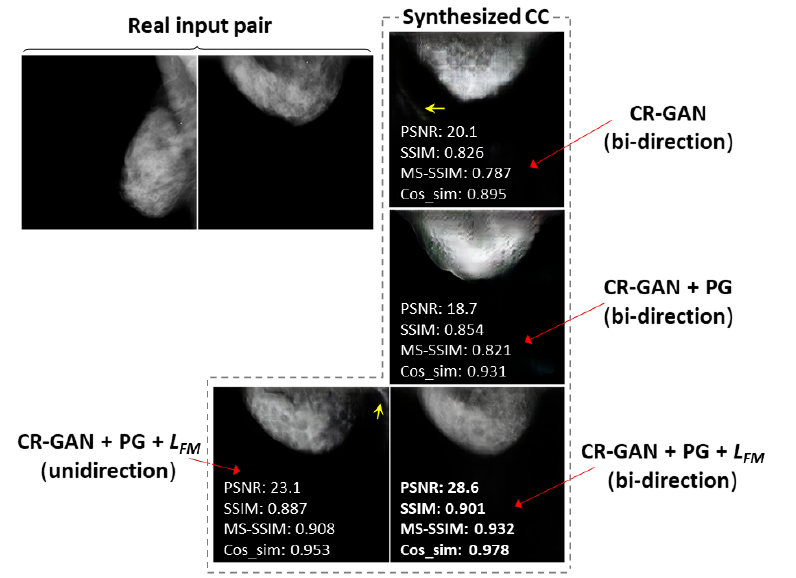
Figure 7. Comparison of synthesized CC views at 256 × 256 resolution by training methods. Examples chosen of a successful case using bi-directional training with PG technique and feature matching loss. The yellow arrows indicate artifacts outside the